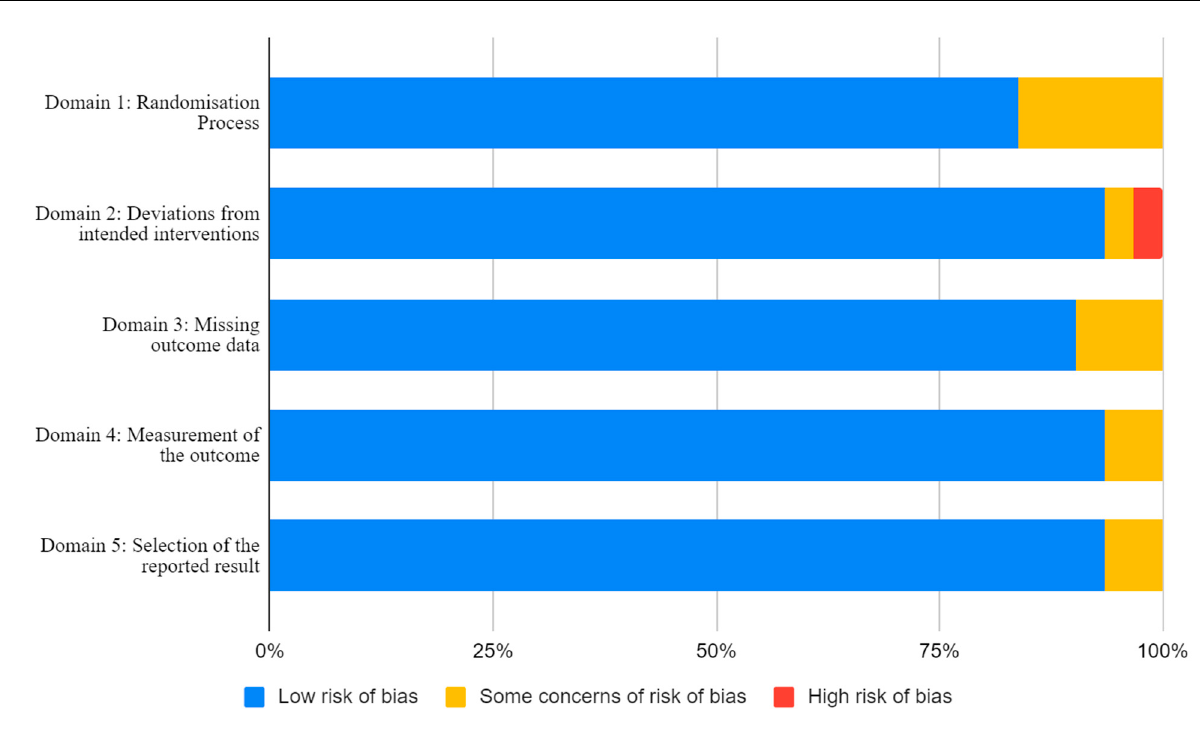
Figure 2. Risk of bias assessment using the revised Cochrane risk-of-bias (RoB 2).